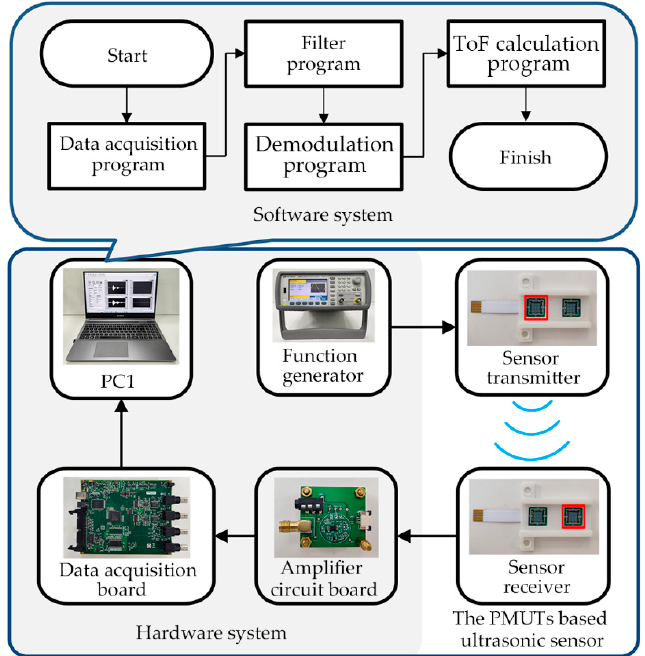
Figure 3. The hardware and software parts of the sensor system.